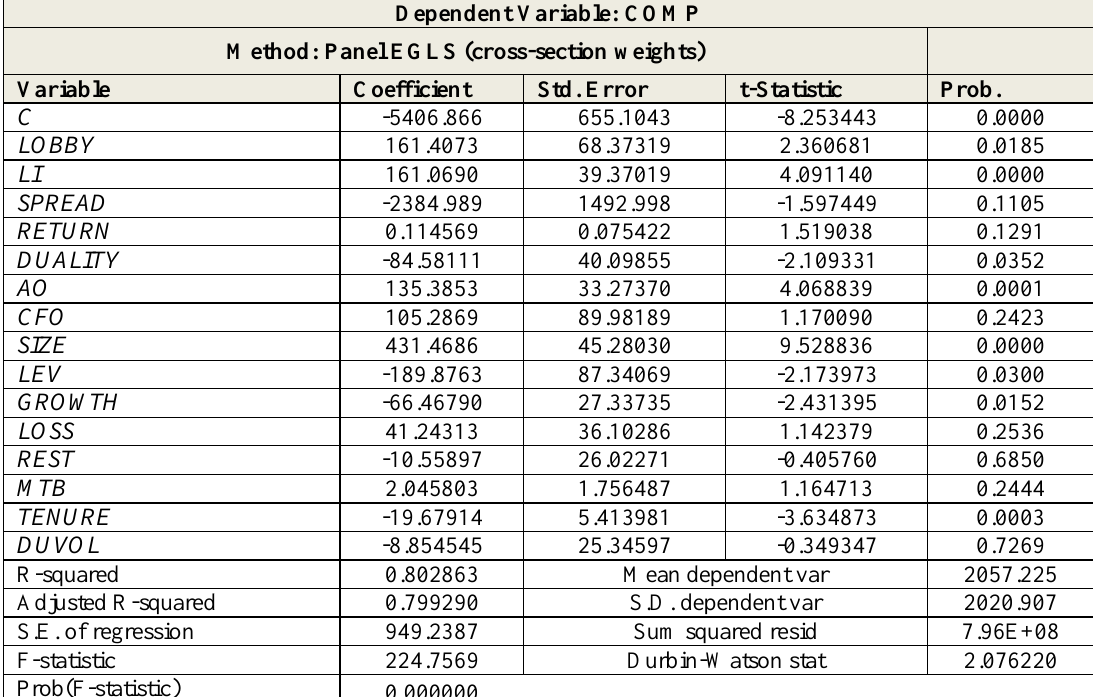
Table 6. Estimation results of model